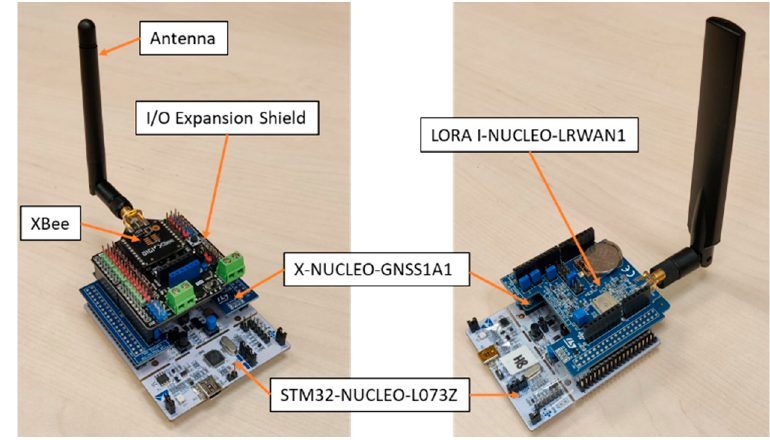
Figure 10. Implemented nodes: ZigBee ( left ) and LoRaWAN ( right ).